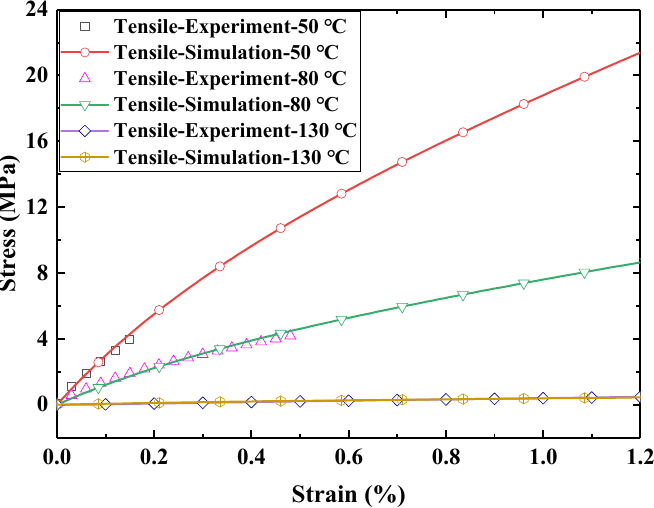
Figure 14. Comparison between uniaxial tension simulation and experimental data.